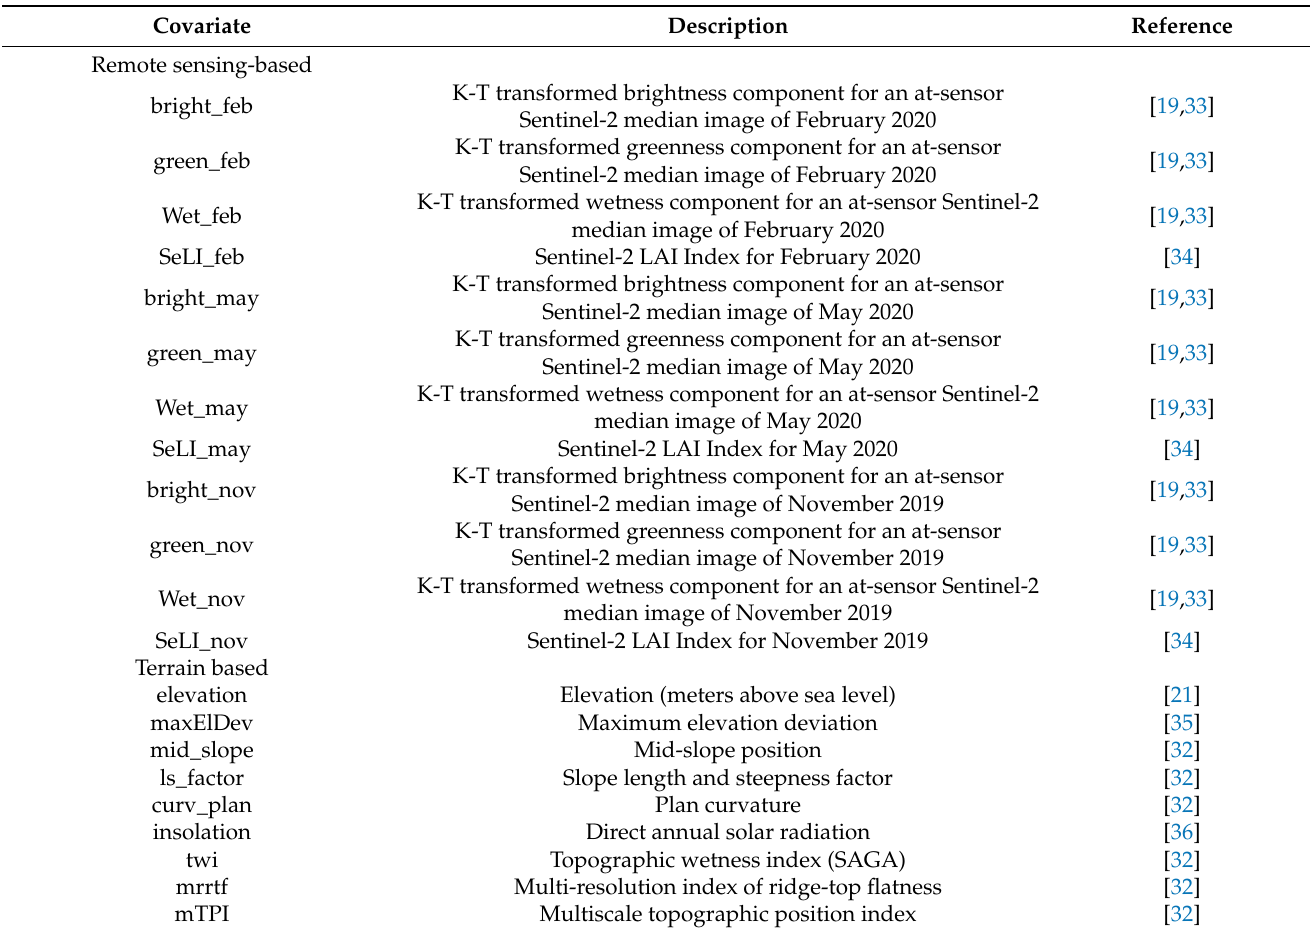
Table 2. Covariates used to build predictive